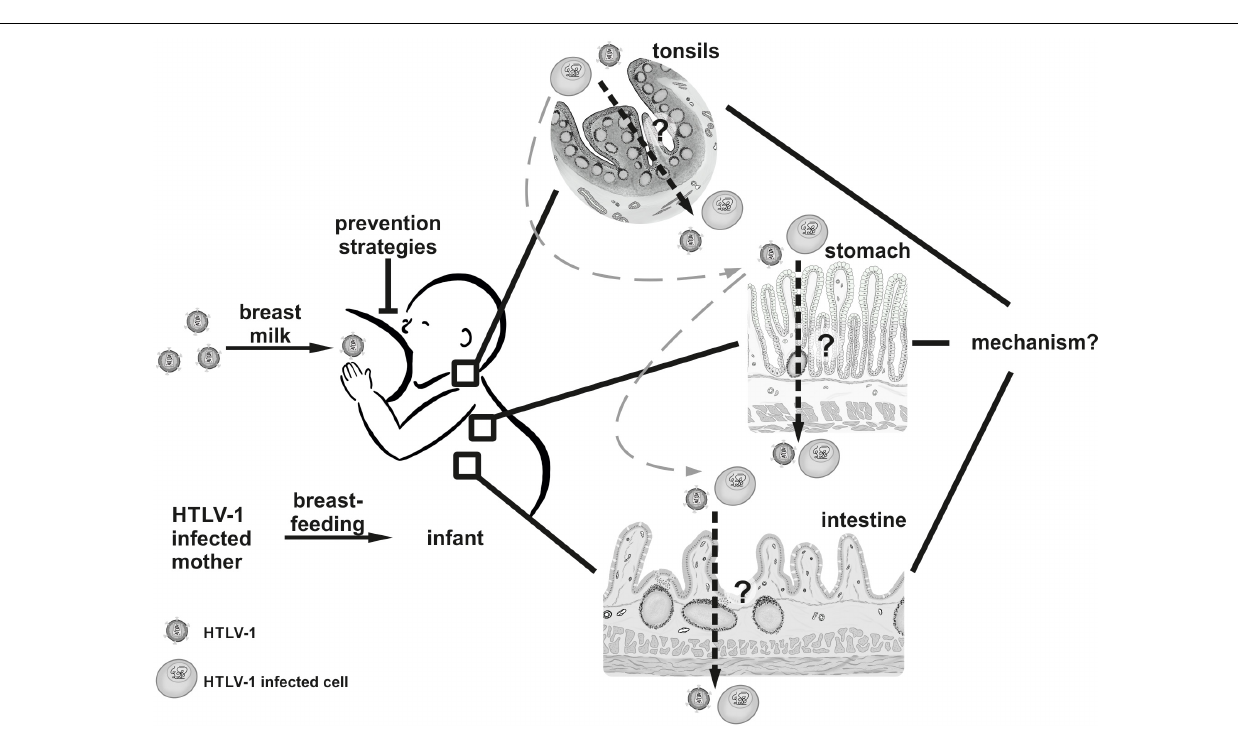
FIGURE 2 | The oral route of HTLV-1 transmission. HTLV-1 is transmitted from mother to child via breastfeeding. It remains to be determined (1) whether HTLV-1 or HTLV-1-infected cells cross epithelial barriers in the tonsils, the stomach, or the intestine of the infant in vivo, and (2) by which mechanisms the virus is transmitted in vivo . Tissues and cells displayed in this figure were drawn manually by Annika P. Schnell with Procreate R (cid:13) Version 5.2.4 (Hobart, Tasmania) on the Apple iPad Pro 11" 2020 (Cupertino, United